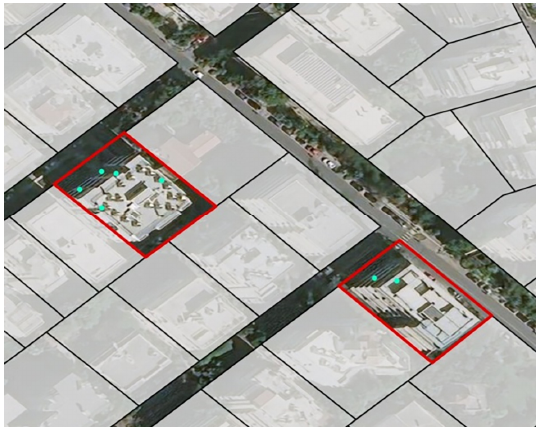
Figure 14. Example of more than one PS point appearing over each newly constructed building. Polygons refer cadastral land parcels.